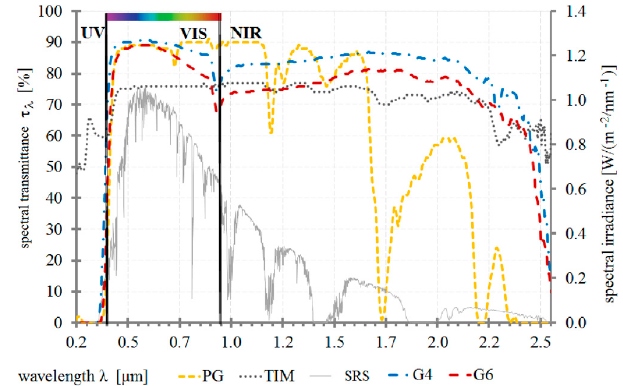
Figure 2. Spectral analysis of transparent samples; spectral transmittance for UV/VIS/NIR region.